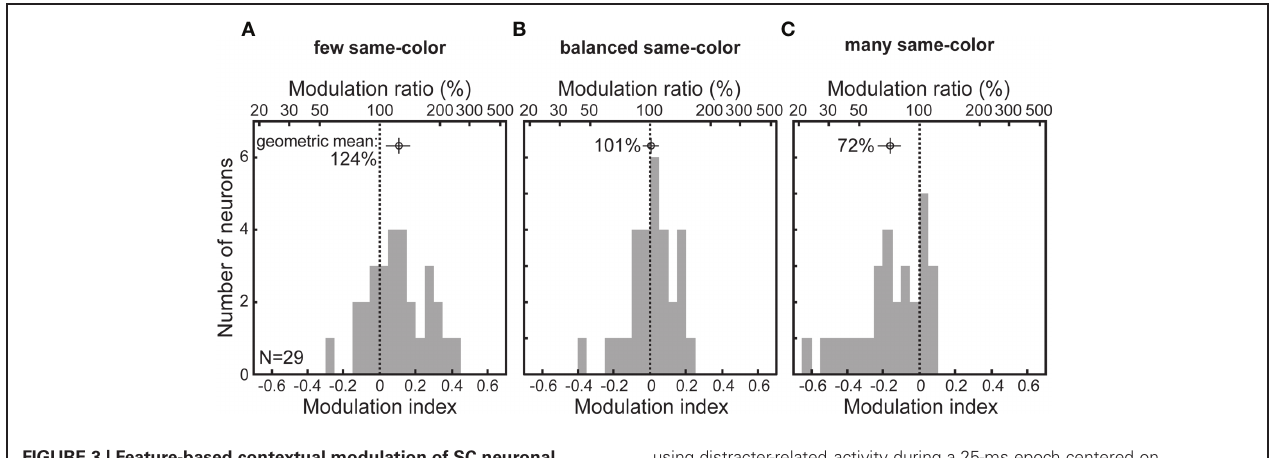
FIGURE 3 | Feature-based contextual modulation of SC neuronal activity. (A) few same-color, (B) balanced, and (C) many same-color displays. The modulation index (MI) was calculated for each neuron